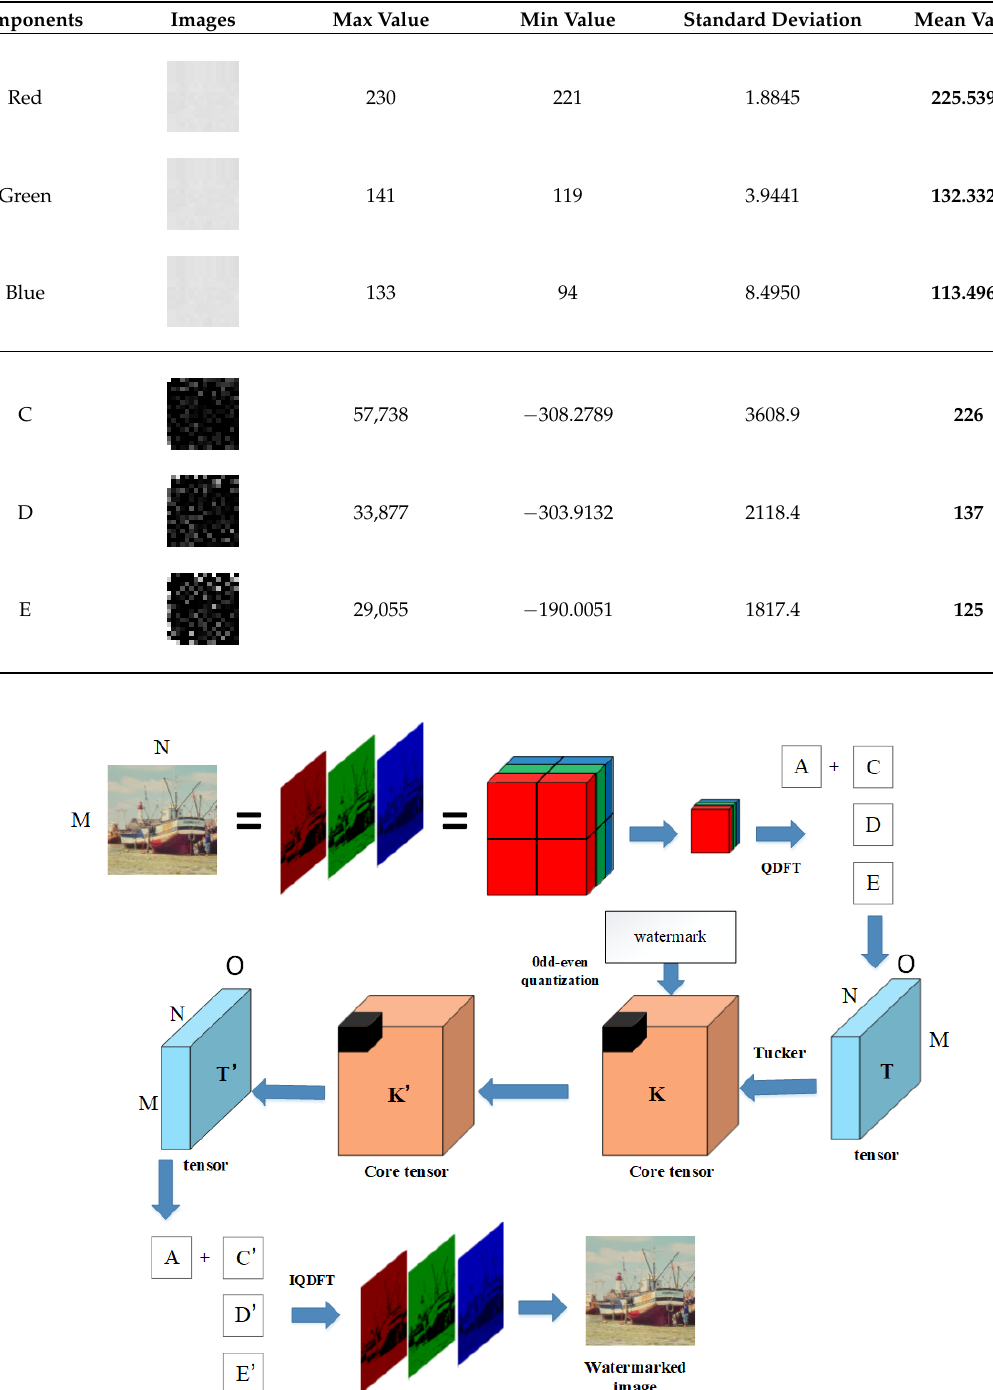
Figure 7. Flowchart for watermark